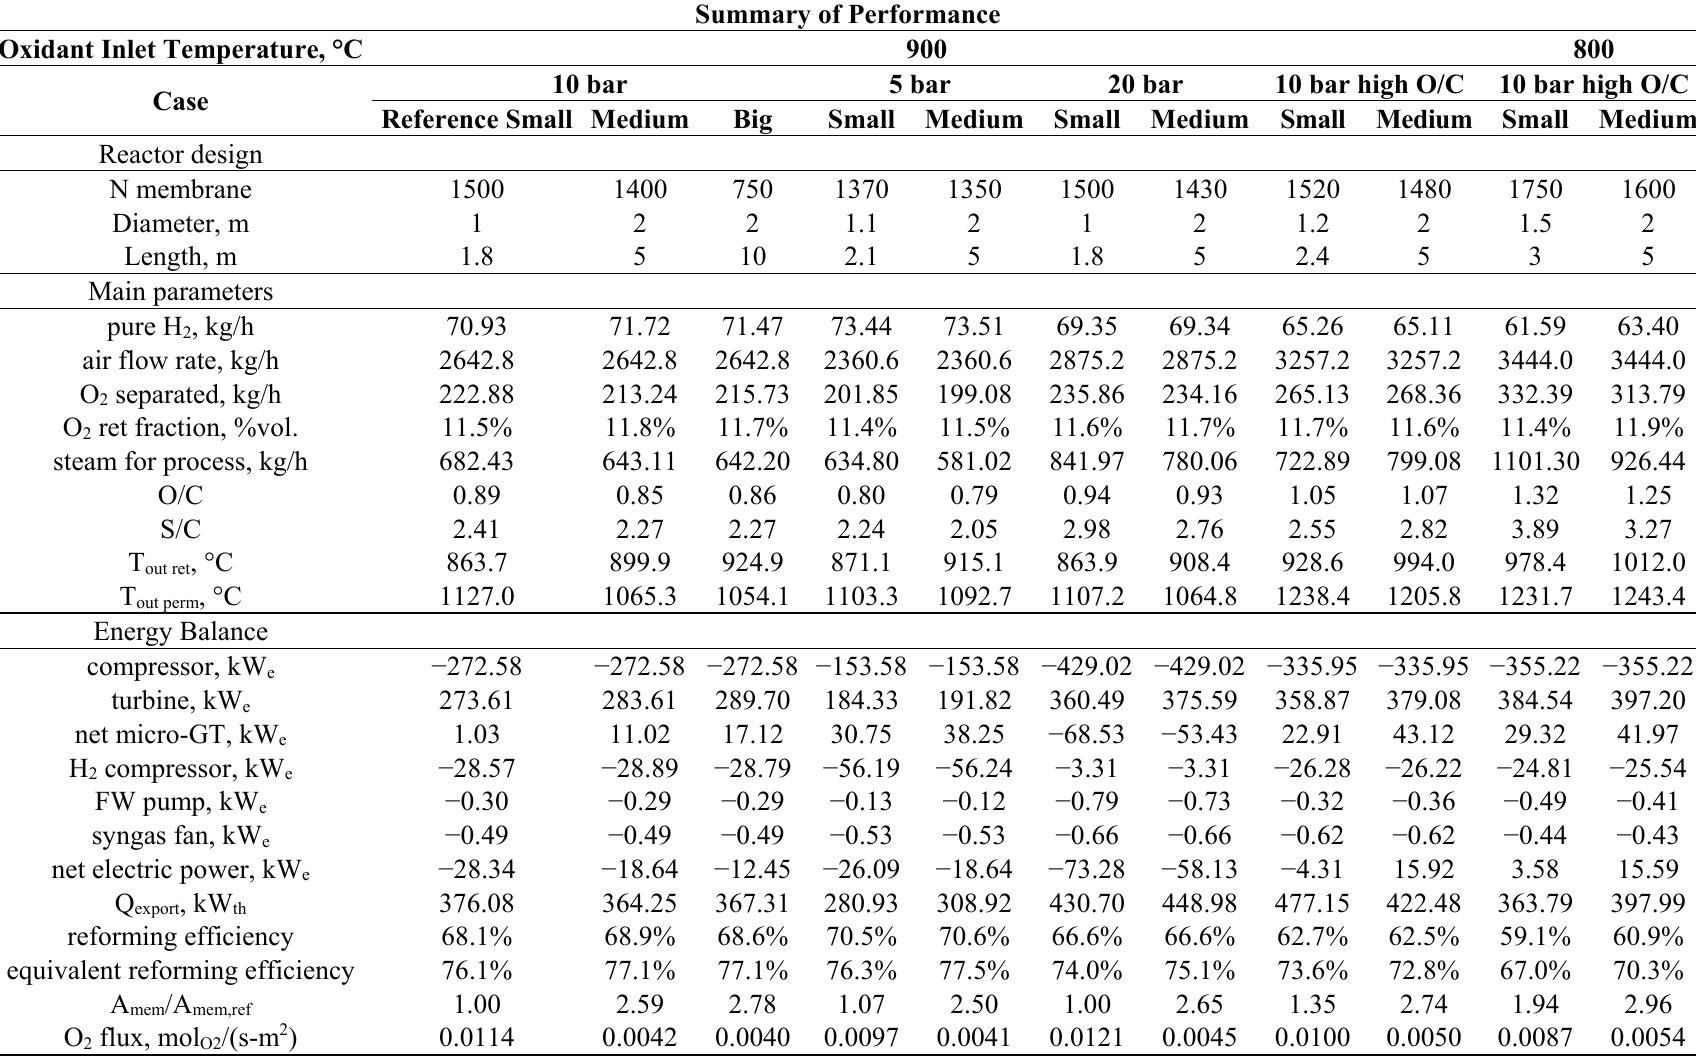
Table 6. Results of the sensitivity analysis. Summary of